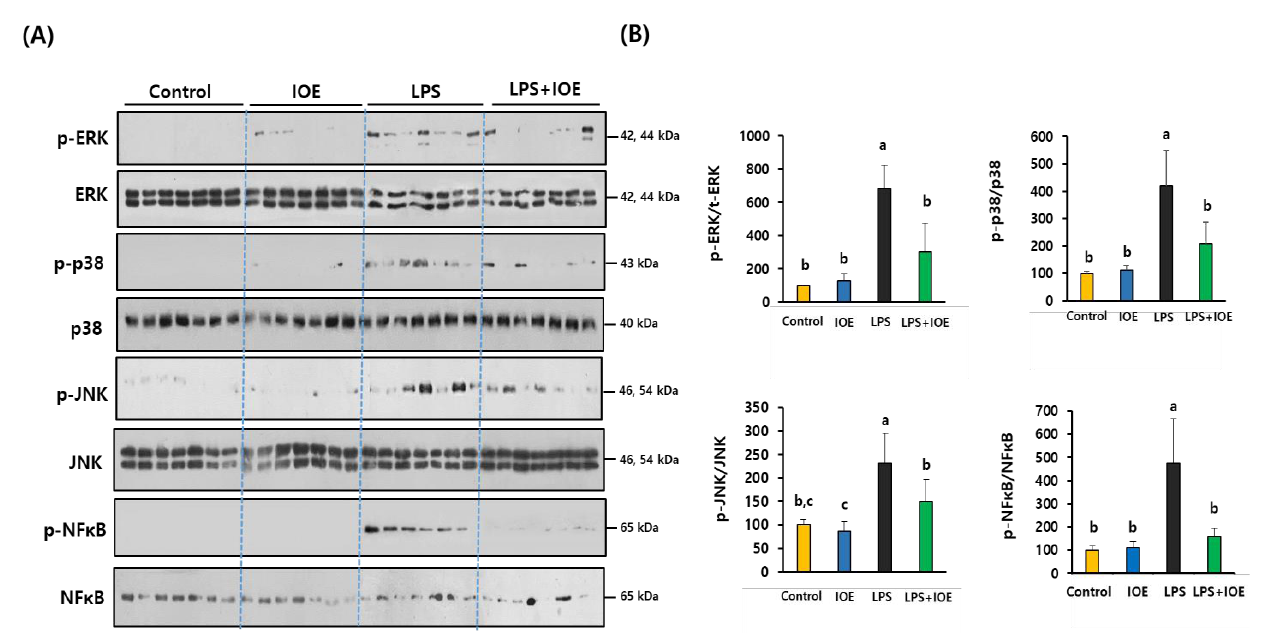
Figure 5. The expression of TLR-4 and MyD88 in brain tissue of LPS-injected mice was attenuated by oral administration of IOE. Total protein was extracted from brain tissues of each mice group and used for estimating the expression of TLR-4 and MyD88 through western blotting ( n = 7) ( A ). The density of each band was calculated by using Image J program and tabulated ( B ). Data shown are the mean ± SD and different letters (a,b) indicate the significant differences between groups ( p < 0.05). Each value is assigned as a and b sequentially from the highest value.